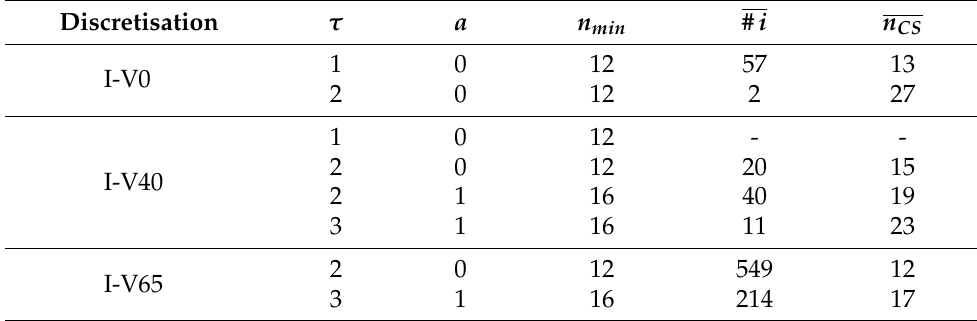
Table 2. Influence of selected RANSAC parameters on the number of iterations # i and the size of the consensus set n CS . The results are averaged over 10 applications. ’-’: no solution is found. Top: regular system of equations, bottom: singular system of equations